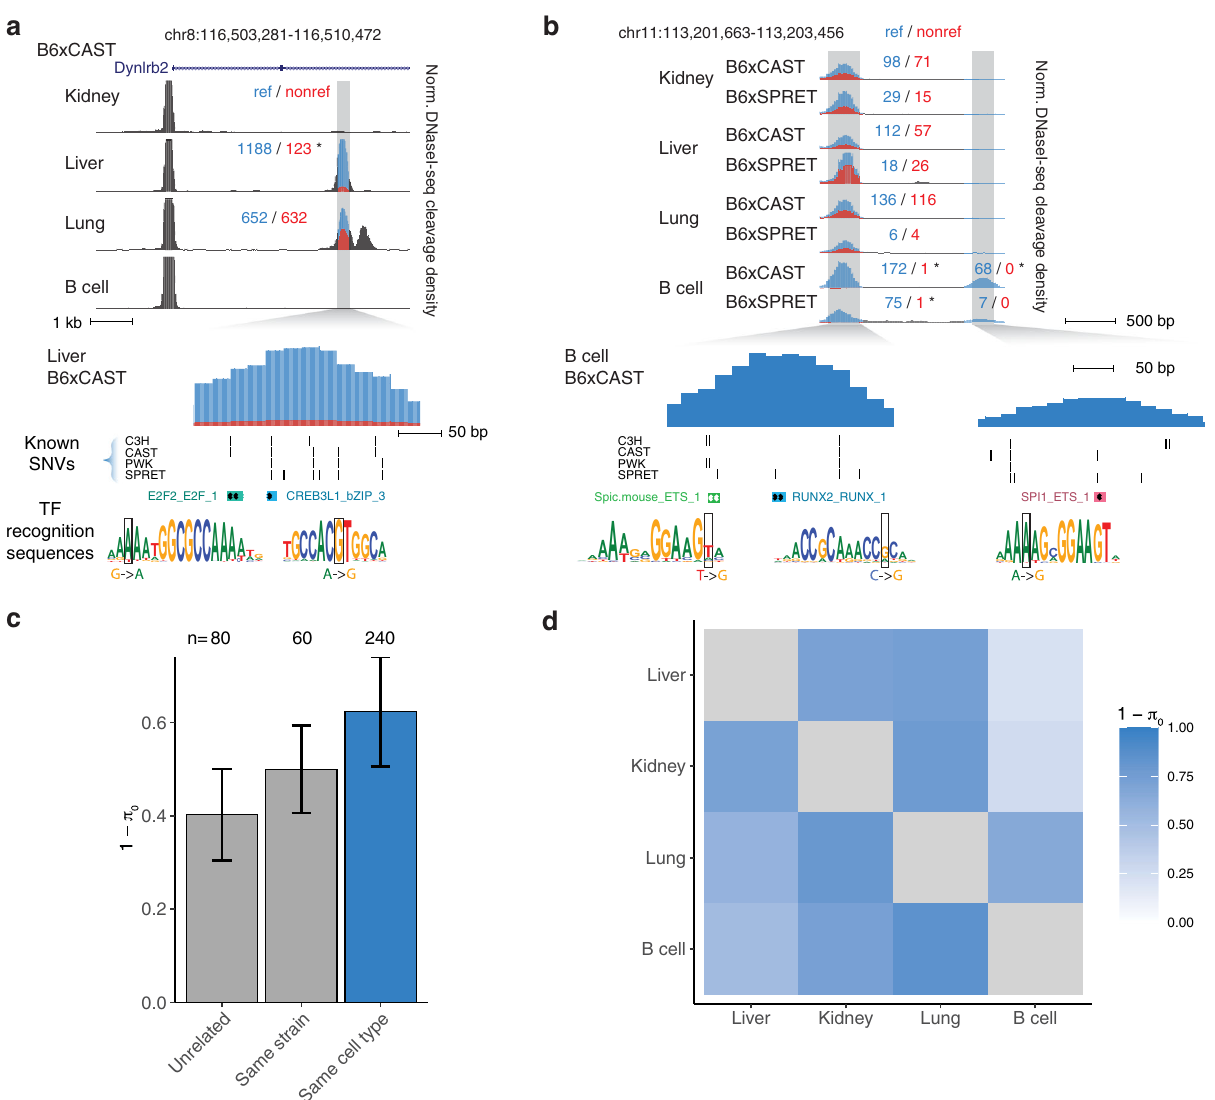
Fig. 3 Cross-cell type analysis of allelic variation in DNA accessibility. a , b Example DHSs showing cell-type-speci fi c imbalance. Normalized DNaseI cleavage density is colored by signal mapping to reference (blue) and non-reference (red) alleles based on the aggregation of informative SNVs. Counts by peaks denote the sum of reads mapping to reference and non-reference alleles for all SNVs in region; *indicates statistically signi fi cant allelic imbalance. Selected TF recognition sequences overlapping imbalanced SNVs are highlighted below. a DHS accessible in liver and lung but with imbalance only in the liver. b . DHSs accessible in all 4 tissues (left) or speci fi c to B cells (right); both DHSs only show an imbalance in B6xCAST and B6xSPRET B cells. c – d Sharing of imbalance by cell type. 1 – π 0 represents the proportion of rejected null hypotheses by Storey ’ s method. c Average sharing of imbalance (1 − π 0 ) between samples of the same cell type vs. samples sharing only the same strain or unrelated samples (sharing neither strain nor cell type). Bar height represents the mean of all pairwise comparisons; error bars represent standard deviation. d . Pairwise sharing of imbalance between cell or tissue